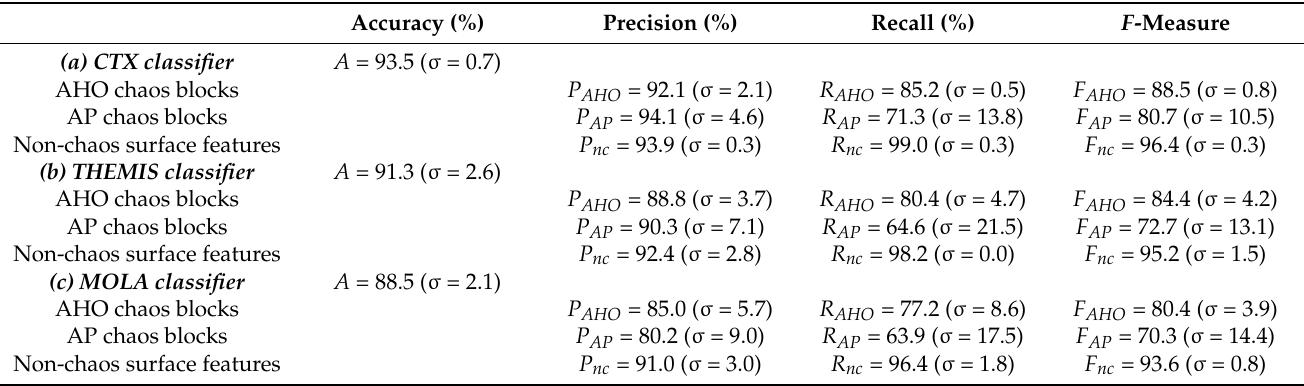
Table 1. Summary of average accuracy rates, precision rates, recall rates, and F -measures with their errors (1 σ ) for the CTX, THEMIS, and MOLA classifiers. Results for 4 Division images and a batch size of 64. See Supplementary Table S1 for the results for 16 Division images and a batch size of 32 and 64. We adopted the parameter set of Table 1 for application to Martian chaos